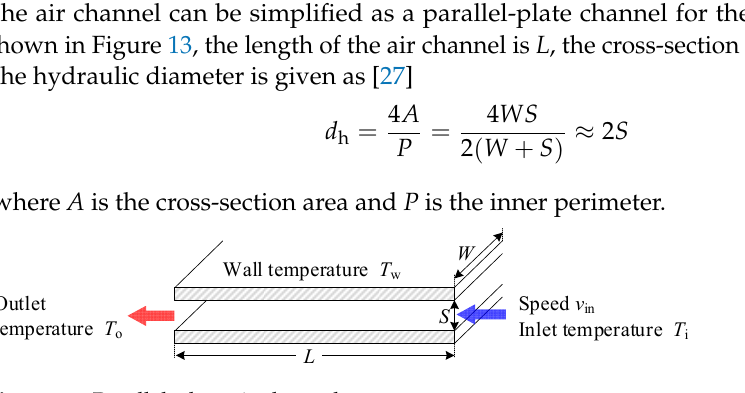
Figure 13. Parallel-plate air channel.